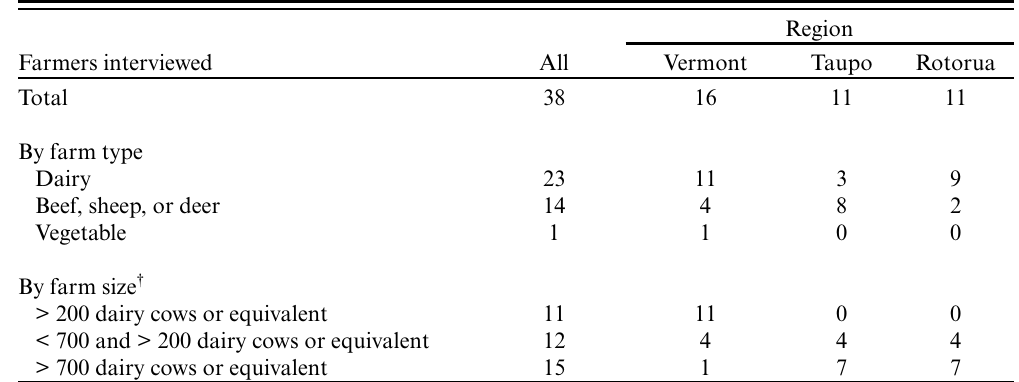
Table 2 . Interview sample across regional policy contexts